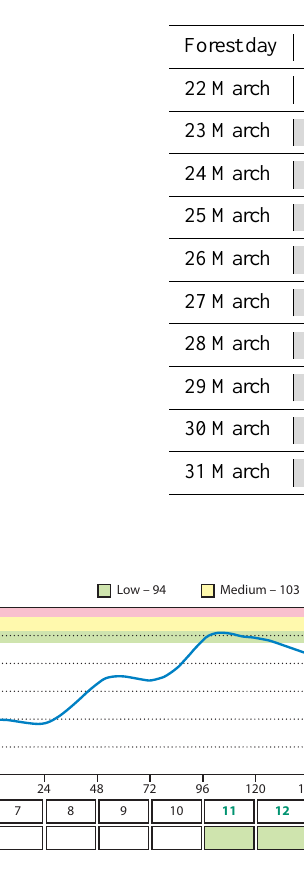
Fig. 2. Threshold exceedance on the example of a forecast issued by the European Flood Alert System. In the top figure, the blue line represents a single deterministic forecast. The plot shows three different warning levels (green, yellow and red). The threshold ex- ceedance of the green level is shown in the table plot underneath. When an ensemble of forecasts is used (rather than just one deter- ministic forecast) the number of ensemble members exceeding the threshold level would be also shown in the table